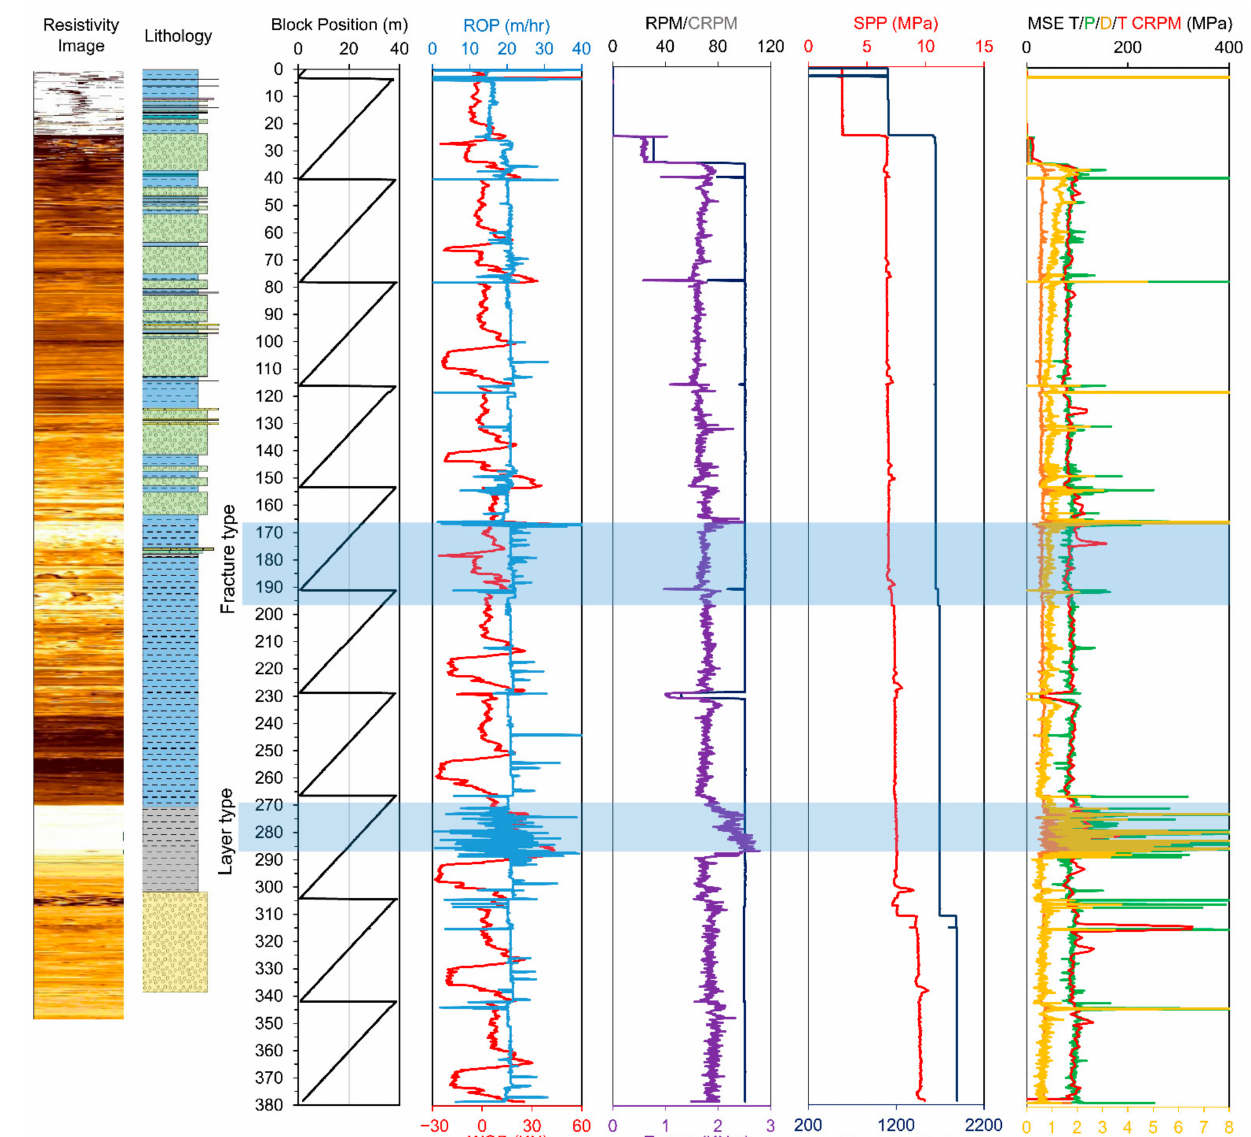
Figure 4. An example of converted time-based drilling parameters to depth-based together with calculated MSE/EST used for analysis for NGHP-02-23A well. Light blue shaded areas between 165.3–198.5 mbsf and 270–288.6 mbsf represent gas hydrate accumulations defined from seismic imaging and downhole